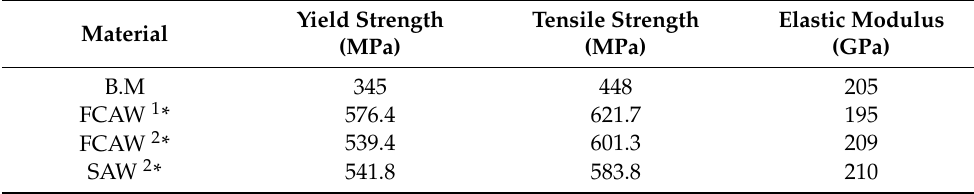
Table 3. Mechanical properties of API 2W Gr.50 steel at room temperature.